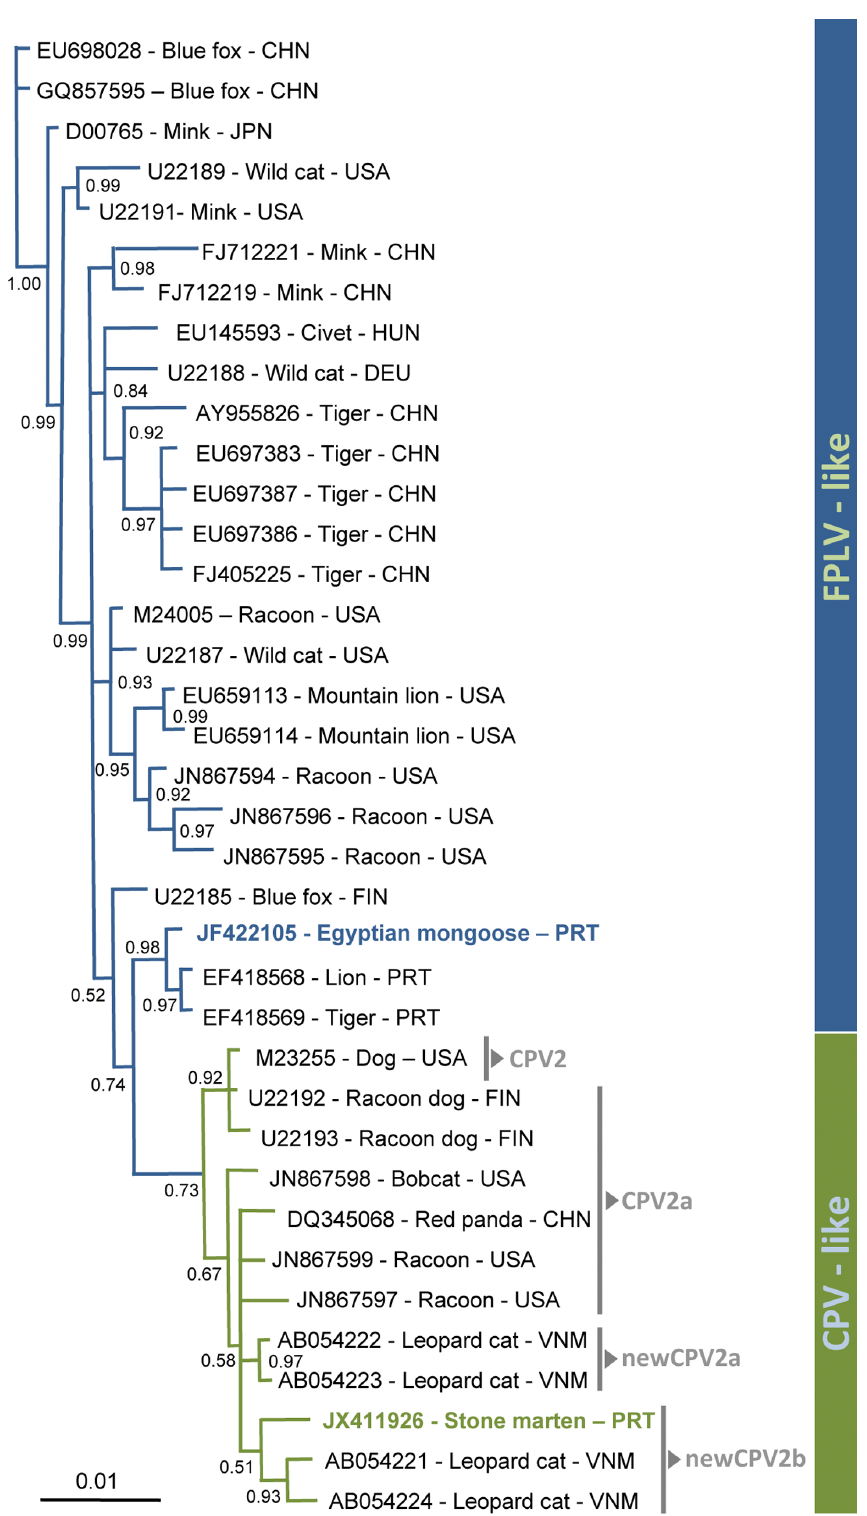
Figure 5. Bayesian Analysis. Bayesian analysis of the vp2 complete nucleotide sequences from one mongoose and one stone marten obtained during this study and other wild carnivore parvoviruses available in Genbank (Table S1). A phylogenetic tree was obtained with a Bayesian inference of phylogeny throughout the MrBayes v3.1.2 software, using the GTR model (nst=6) with gamma-shaped rate variation with a proportion of invariable sites (rates=invgamma). The analysis was performed with ngen=10 6 , nchains=4 and samplefreq=10. The numbers included on each boot strap represent the Bayesian posterior probability.